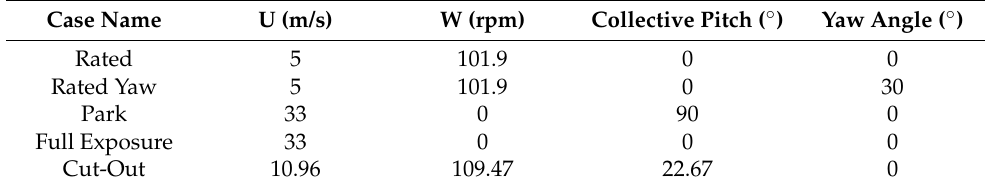
Table 6. The evaluated design load cases.